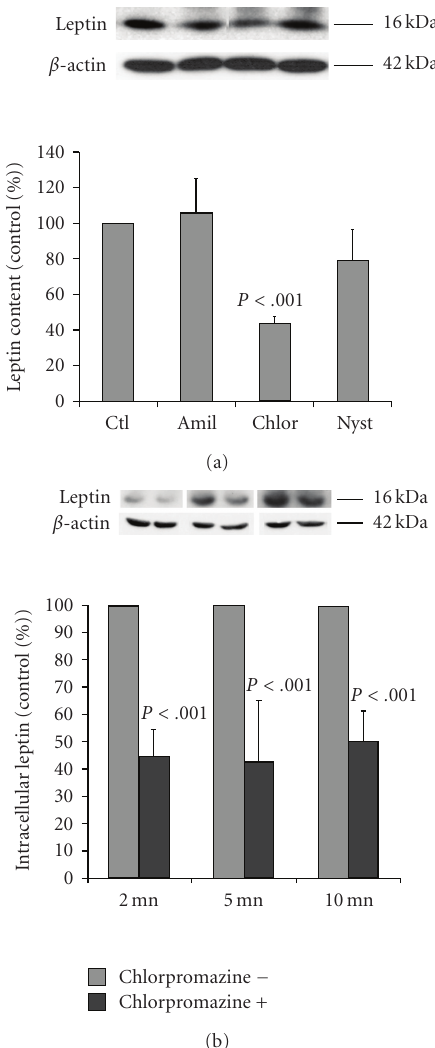
Figure 6: Inhibition of leptin endocytosis . Caco-2/15 cells were preincubated with the following inhibitors of endocytosis: Amiloride (Amil) (3mM), chlorpromazine (Chlor) (6 μ g/mL), and nystatin (Nyst) (25 μ g/mL). Leptin was added to the apical medium for 30 minutes and intracellular leptin contents were measured. (a) A significant decrease was observed only with chlorpromazine treatment. (b) Specificity of chlorpromazine treatment was confirmed by measuring of intracellular leptin at shorter incubation times (2, 5, and 10 minutes). Mean values ± s.e.m ( n =